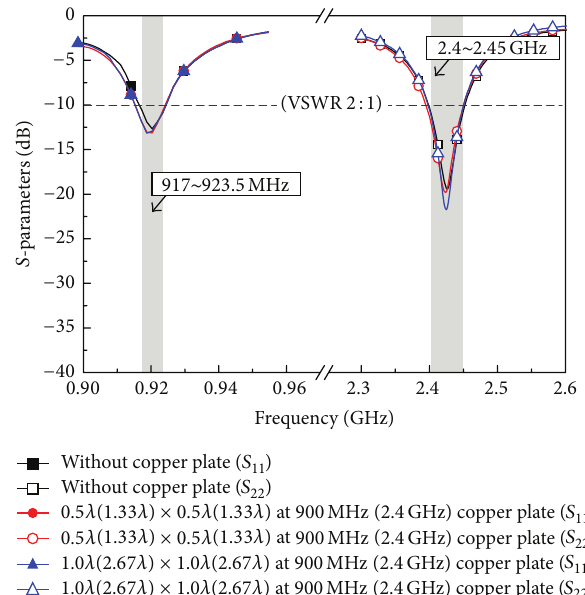
Figure7:Measured S -parametersoftheproposedantennamounted on the different sized metallic objects.